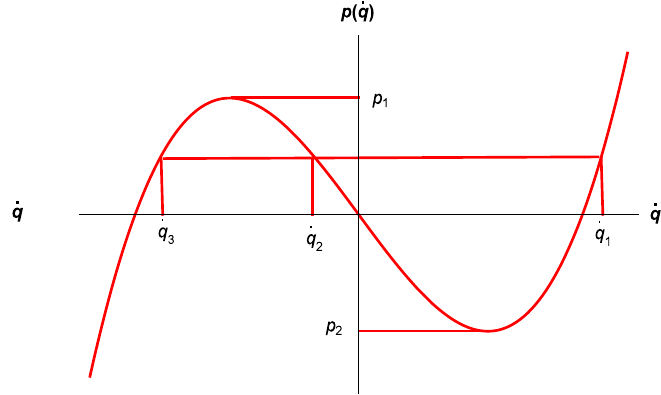
Fig. 1 For α < 0, Legendre map from ˙ q to p shows one to one corre- spondence between the two